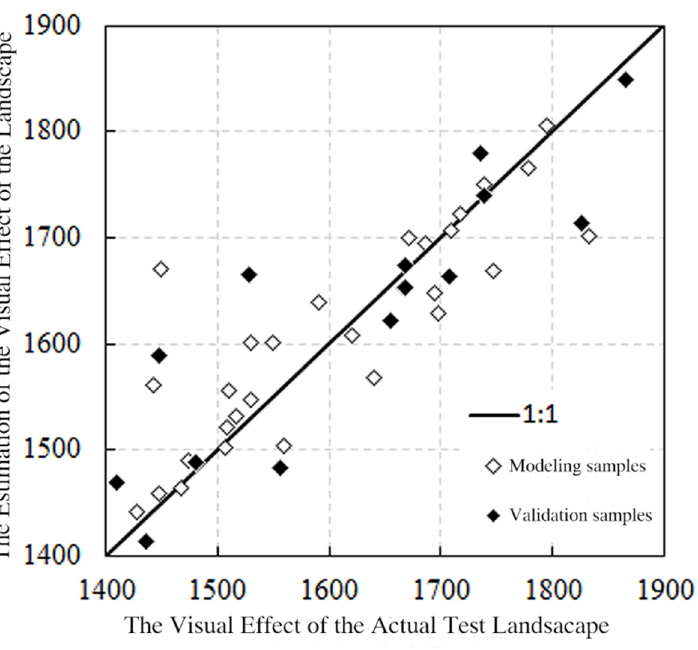
Figure 6. Scatter plot of landscape visual remote sensing